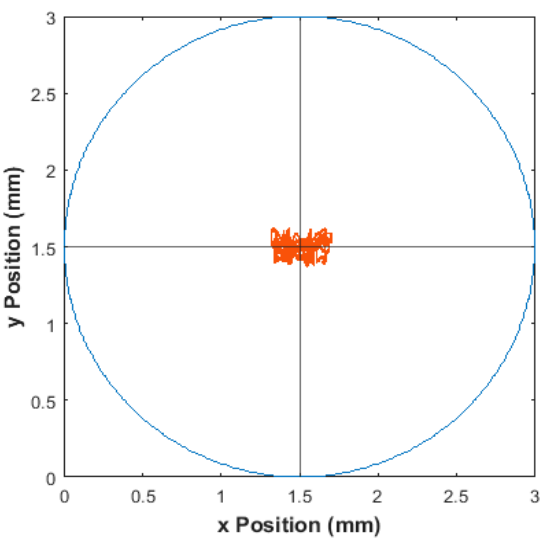
Figure 18. Orbit plot of rotor when spun at 500 rpm, circle represents the allowable limit of movement for the rotor.